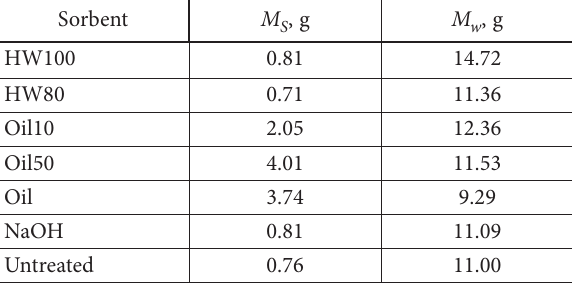
Table 2. Results of water sorption experiment